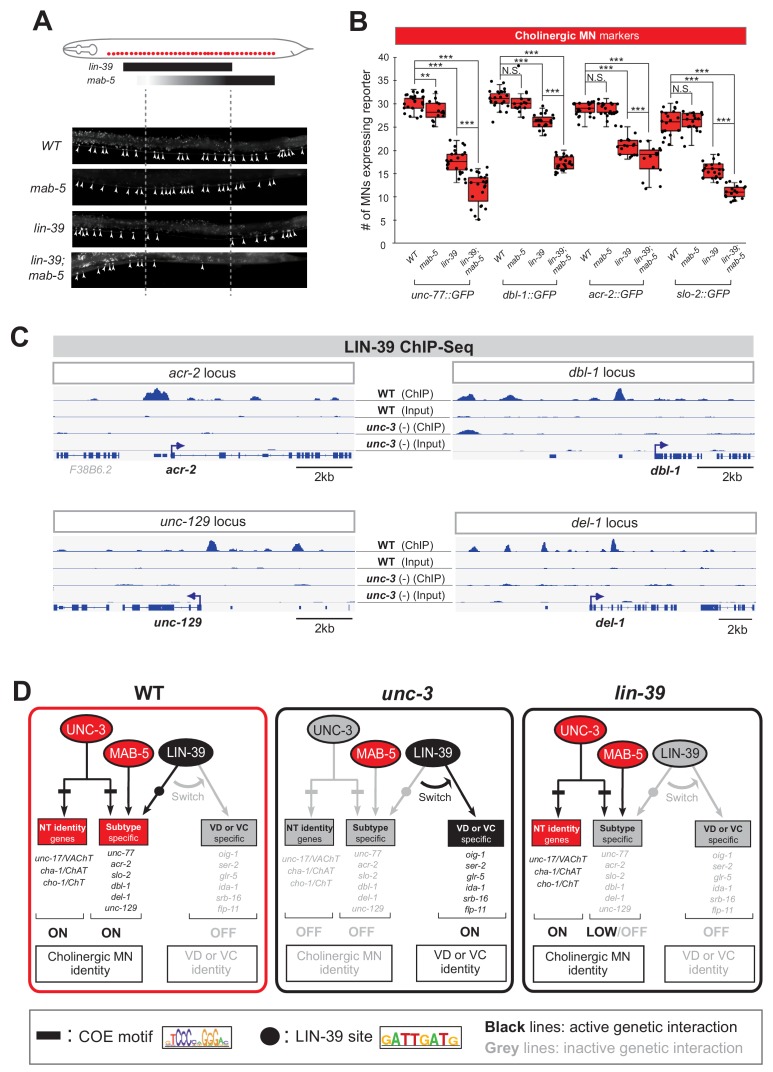
UNC-3 prevents a switch in the transcriptional targets of LIN-39 in cholinergic motor neurons.(A) Schematic summarizing the expression pattern of lin-39 and mab-5 in VNC cholinergic MNs. Below, representative images are shown of unc-77::gfp in WT, lin-39 (n1760), mab-5 (1239) and lin-39 (n1760); mab-5 (1239) animals at L4 stage. Arrowheads point to MN cell bodies with gfp marker expression. Green fluorescence signal is shown in white for better contrast. Dotted black box indicates imaged area. (B) Quantification of cholinergic MN terminal identity markers (unc-77, dbl-1, acr-2, slo-2) in WT, lin-39 (n1760), mab-5 (1239) and lin-39 (n1760); mab-5 (1239) animals at L4. N > 15. **p<0.01; ***p<0.001. (C) ChIP-Seq tracks are shown for LIN-39 on four cholinergic MN terminal identity genes (acr-2, unc-129, dbl-1, del-1). The WT data come from the modENCODE project (Boyle et al., 2014), whereas the unc-3 (-) data were obtained by performing ChIP-Seq for LIN-39 on unc-3 (n3435); lin-39 (kas9 [lin-39::mNG::3xFLAG::AID] animals. (D) Schematic showing the transcriptional switch in LIN-39 targets. In WT animals, UNC-3, MAB-5 and LIN-39 co-activate subtype-specific genes in cholinergic MNs (e.g., unc-77, dbl-1, unc-129, acr-2). In unc-3 mutants, LIN-39 is no longer able to activate these genes, and instead switches to VD- or VC-specific terminal identity genes. Black font: gene expressed. Gray font: gene not expressed. Gray arrows indicate inactive genetic interactions. COE motif taken from Kratsios et al. (2012) and LIN-39 site taken from Weirauch et al. (2014) are represented with black rectangles and dots, respectively.